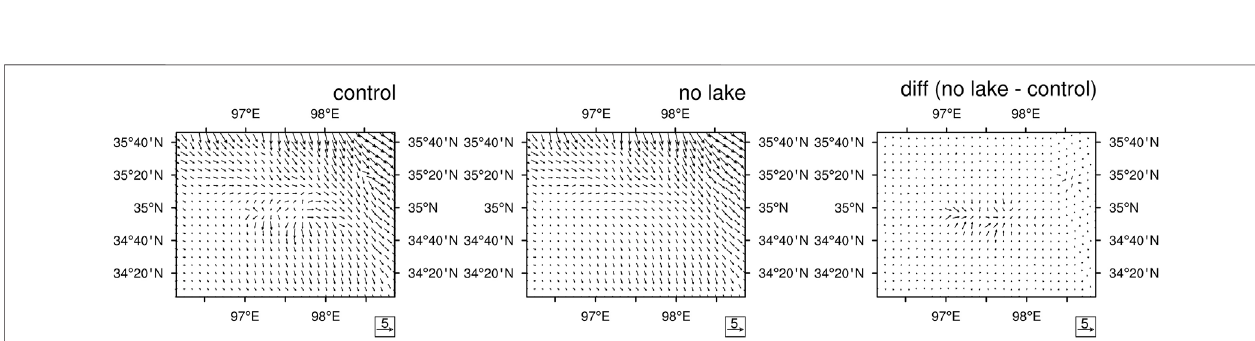
Frontiers in Earth Science |